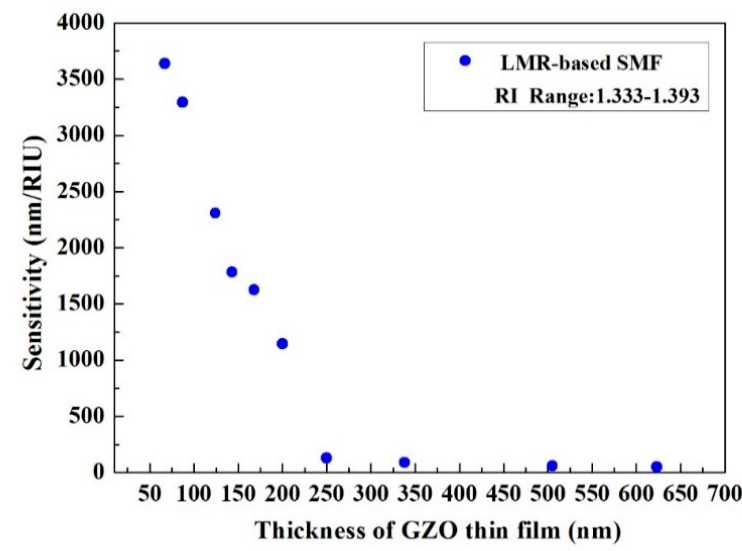
Figure 8. The sensitivity of LMR-type sensors as a function of film thickness.